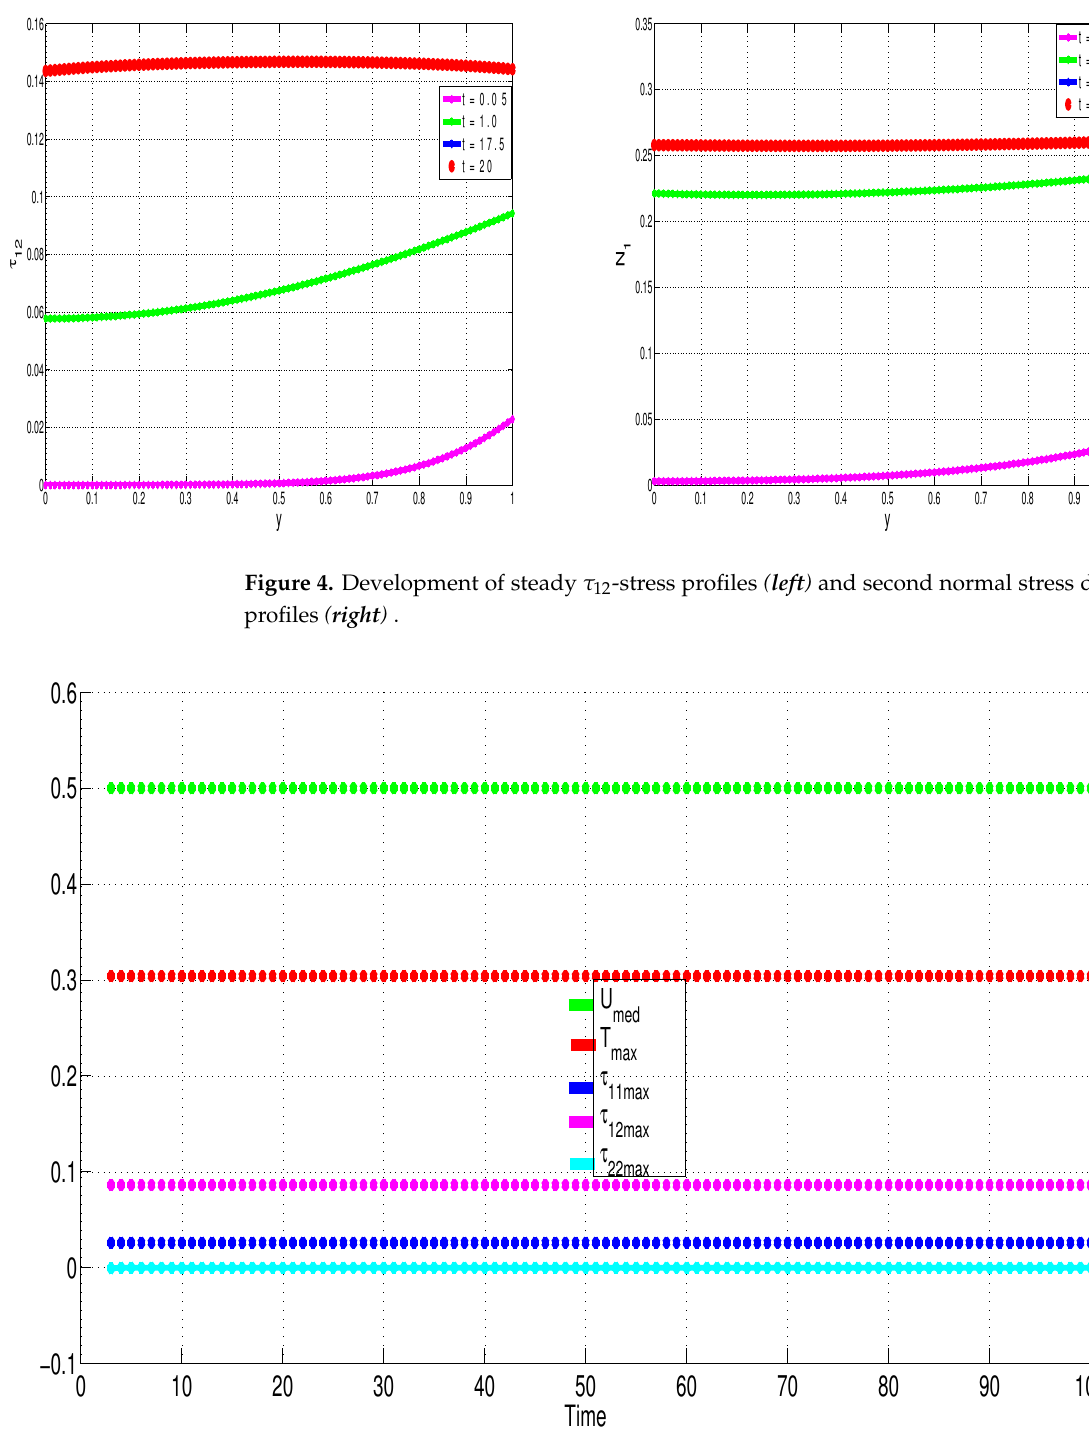
Figure 5. Development of steady maximum flow